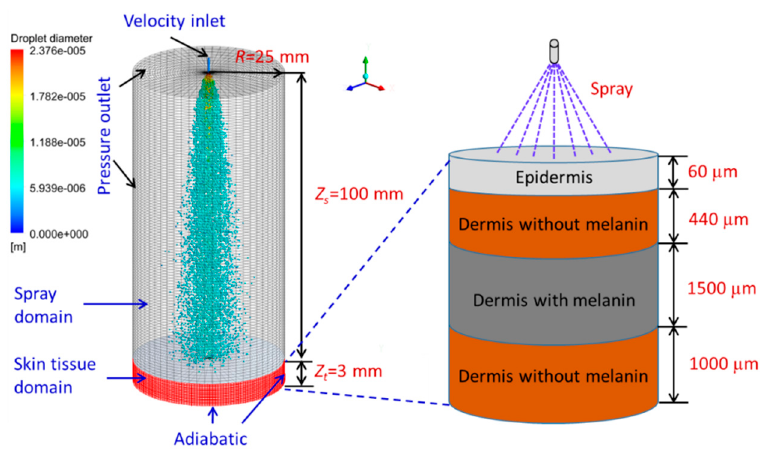
Figure 2. Computational domain and boundary conditions for simulation of cryogen spray cooling.